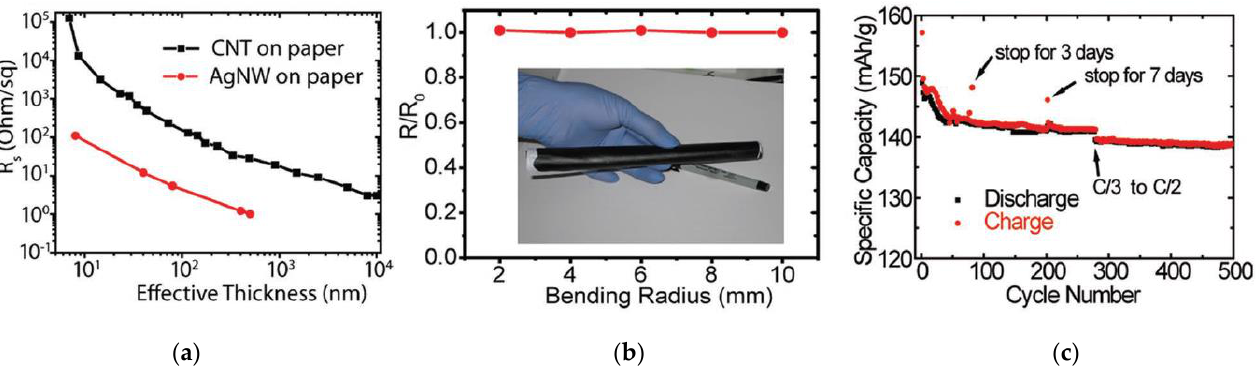
Figure 15. ( a – c ) Electrical performance of conducting paper based on CNTs and Ag. Reprinted from [69]. Published 2009 by National Academy of Sciences as open access.